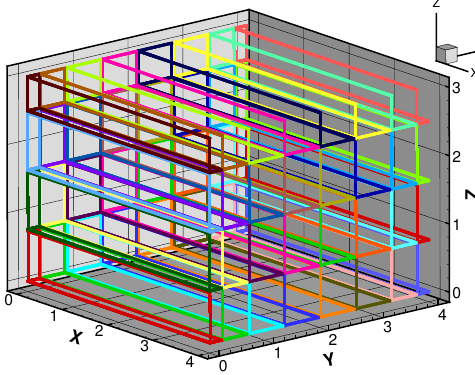
Figure 3. Domain decomposition topology of 8